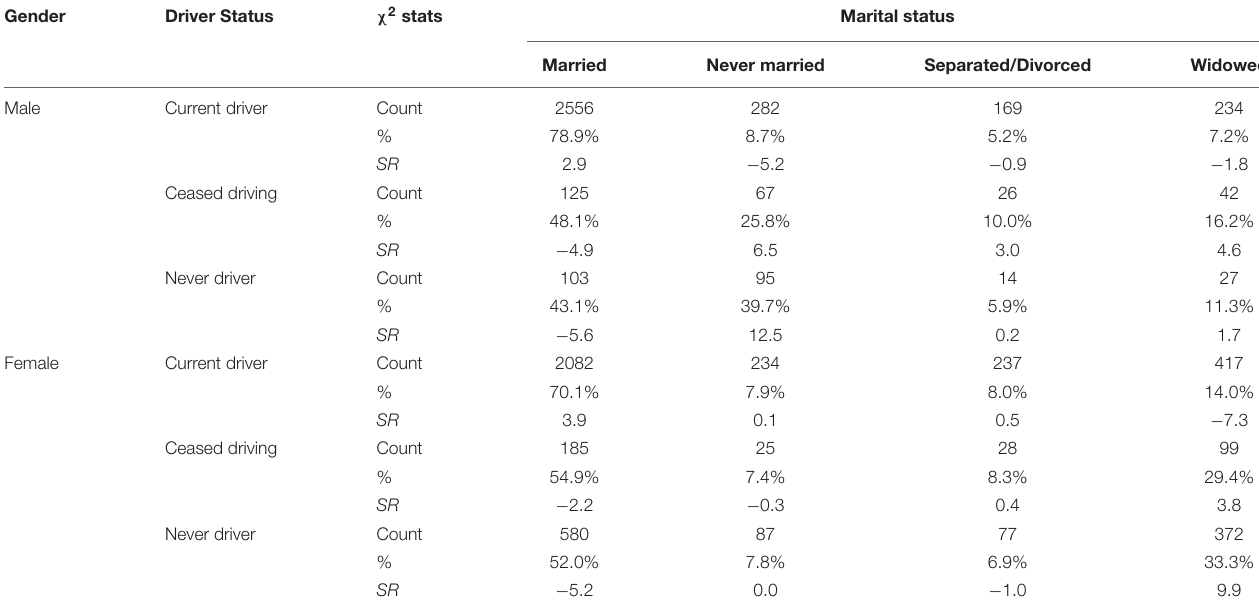
TABLE 3 | Crosstabulation of martial status by driving status for both genders separately. Gender